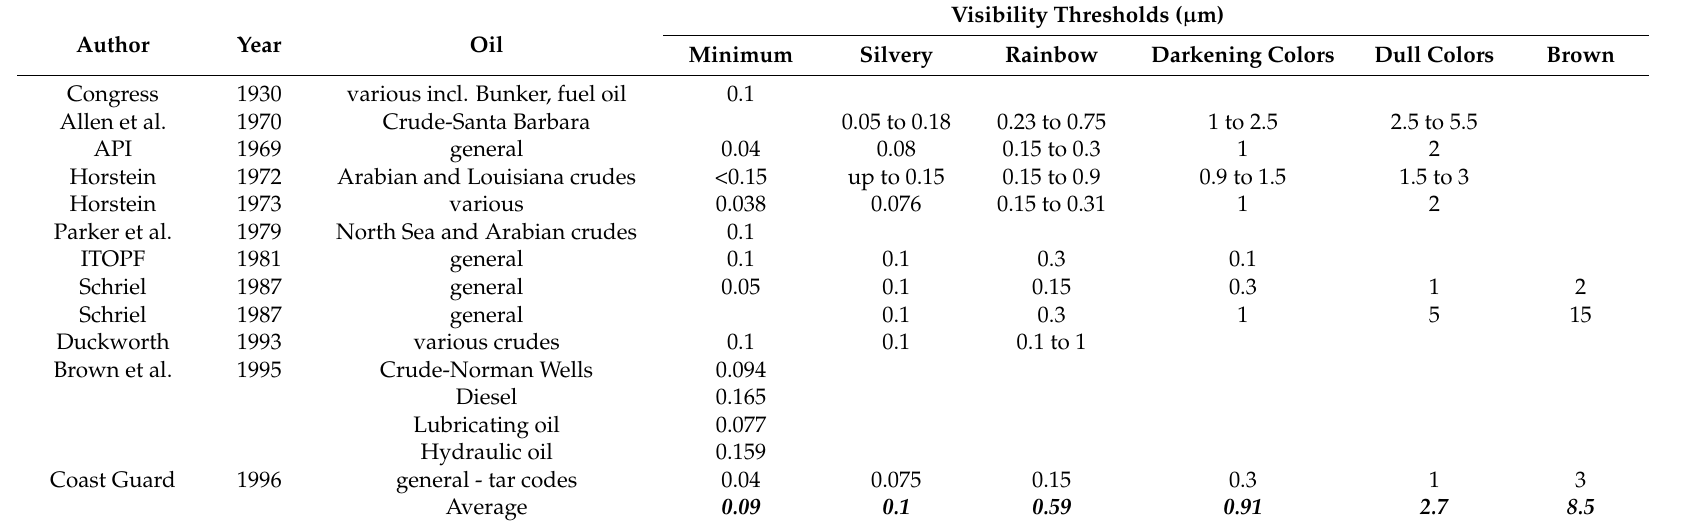
Table 1. Relationships between Appearance and Slick